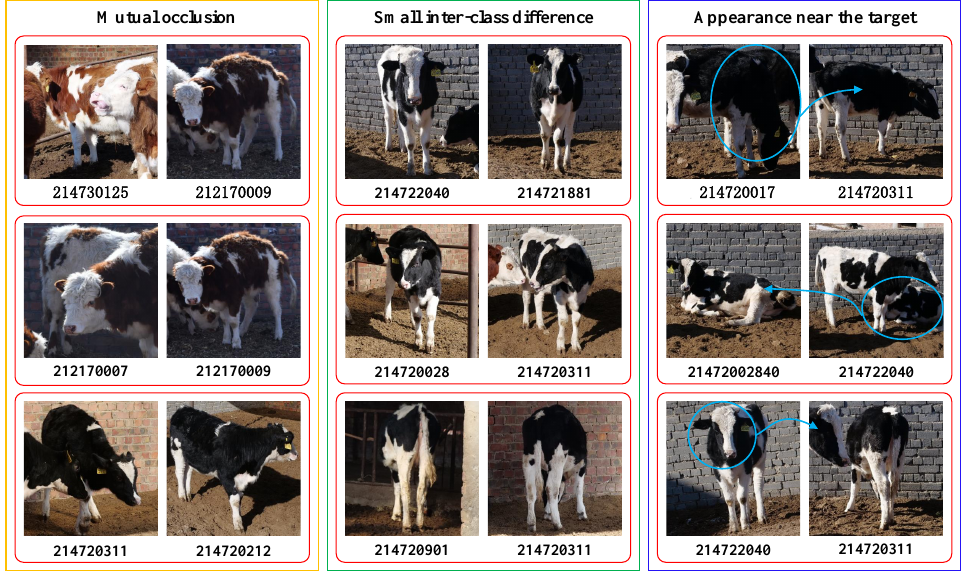
Figure 11. Typical identification errors in CAIDRE with ResNet50. The left image of the pairs in the red box is the test identity, and the right one is its wrongly predicted result. Mutual occlusion, high similarities, and appearance around the target are the main causes of misidentification. Best viewed in